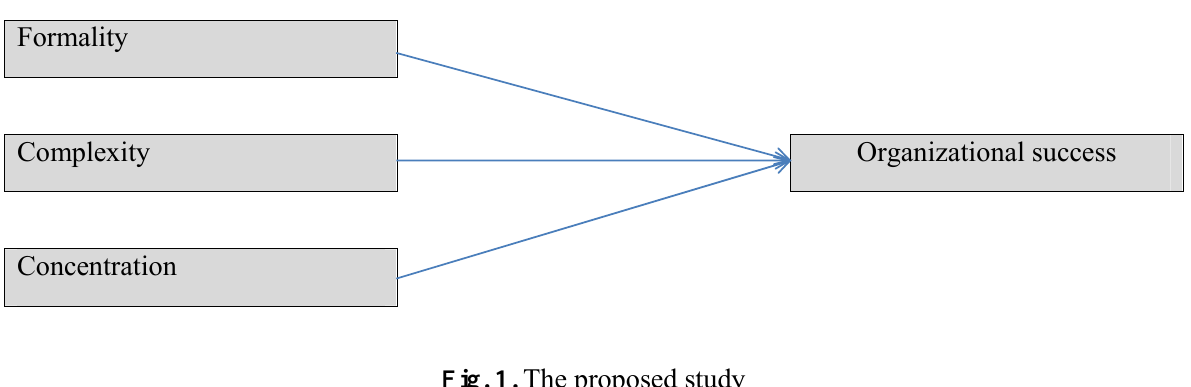
Fig. 1. The proposed study